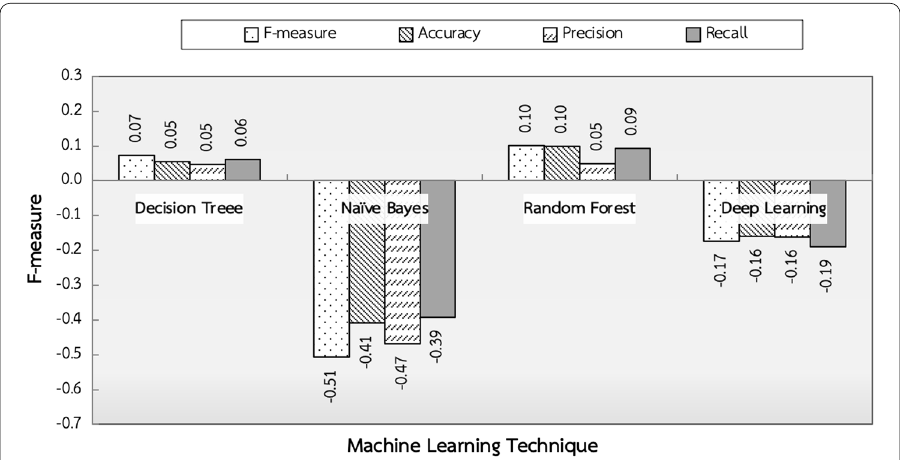
Fig. 8 Performance comparison of machine learning techniques compared with Support Vector